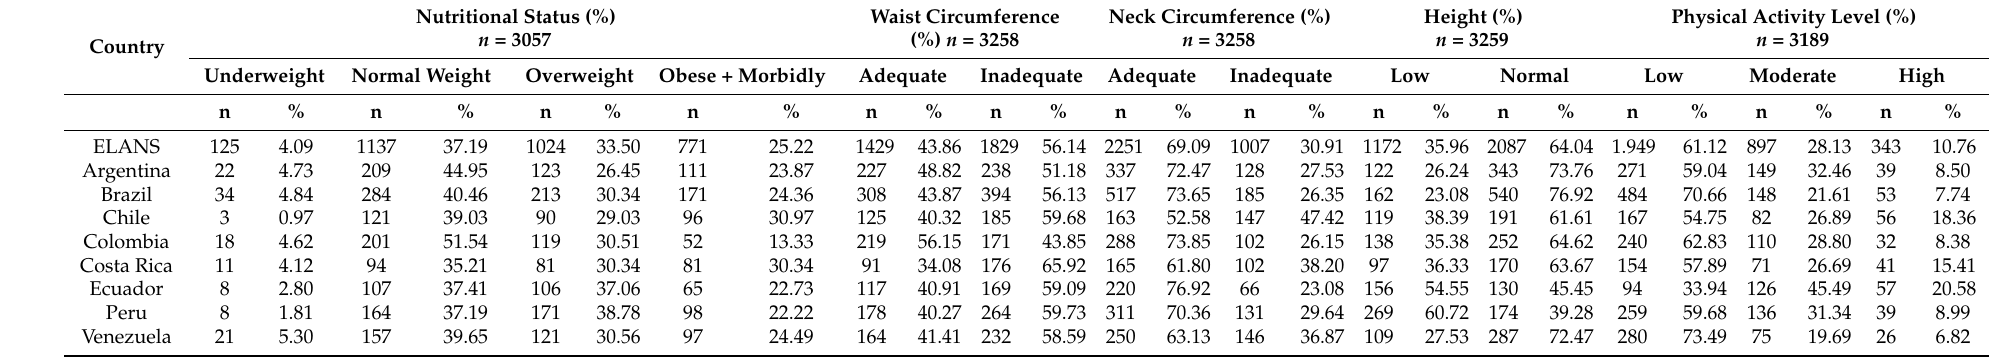
Table 3. Anthropometric and physical activity level prevalence by country among childbearing-age women in the Latin American Study of Nutrition and Health (ELANS),